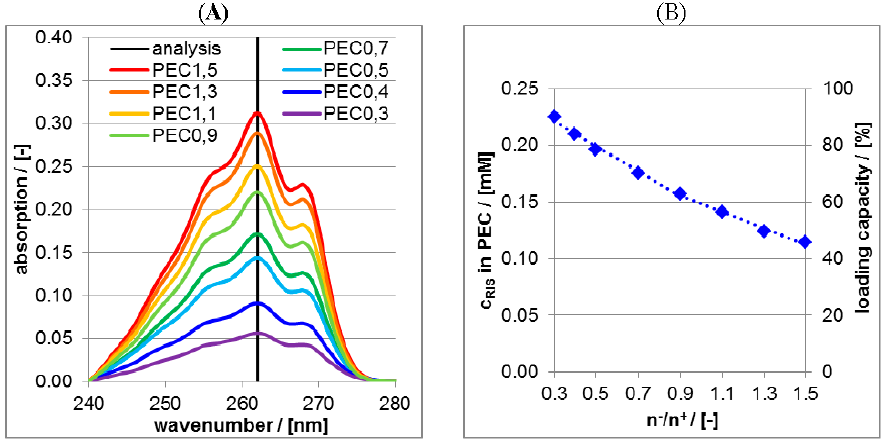
Figure 6. ( A ) Ultraviolet/visible (UV/VIS) spectra of supernatant after centrifugation of RIS-loaded PEC dispersions at pH = 10 for various molar mixing ratios n ´ /n + ; ( B ) Plot of the concentrations (left ordinate axis) and of the loading capacity (right ordinate axis) of RIS in the PEC particles as a function of molar mixing ratio n ´ /n +